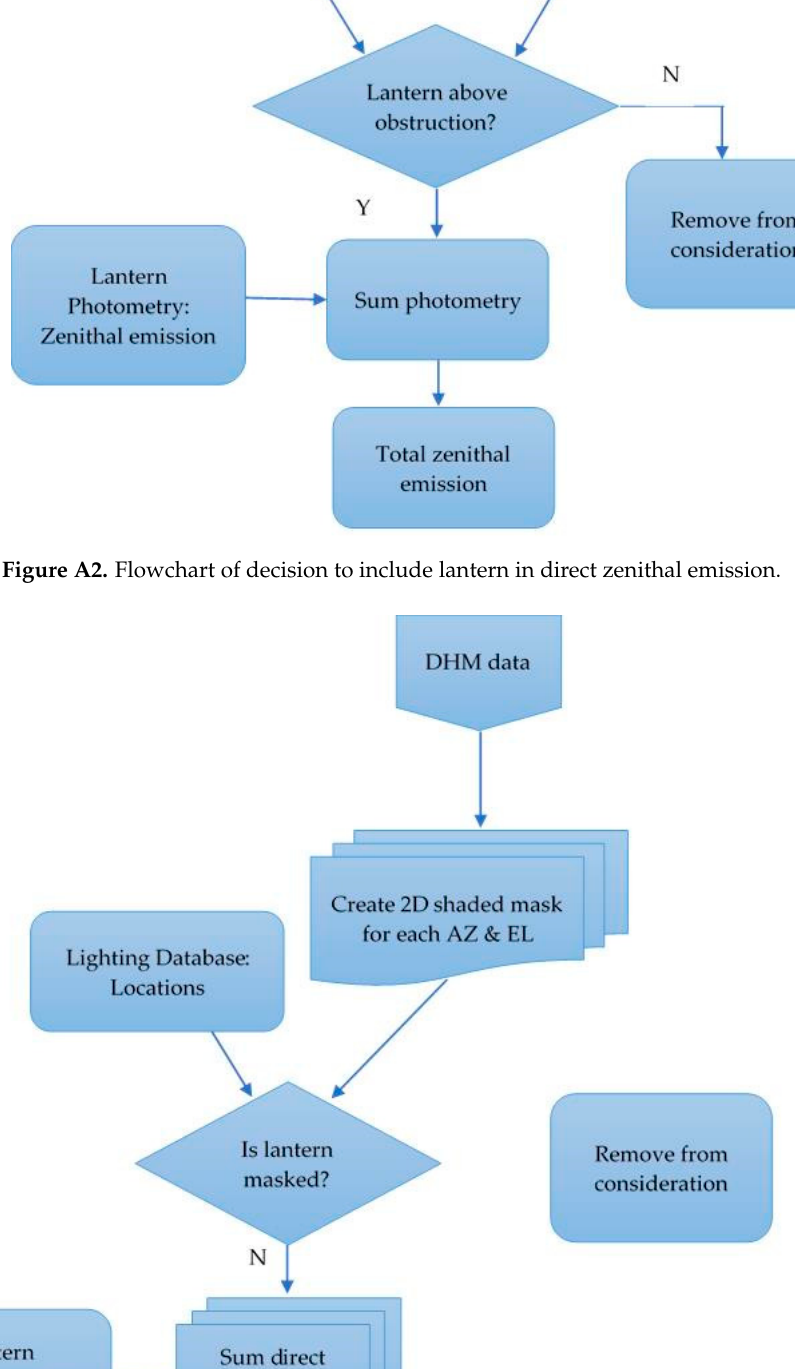
Figure A3. Flowchart of the decision to calculate the direct emission at each chosen